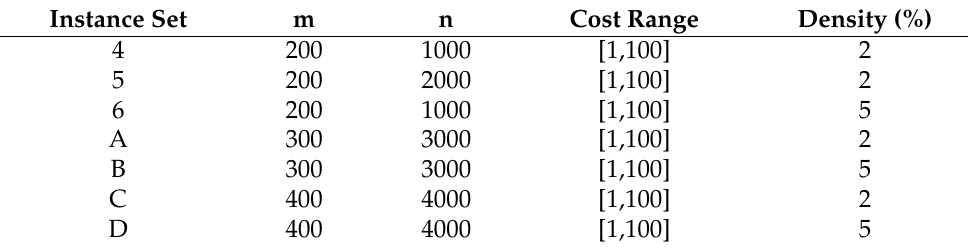
Table 6. Configuration details from SCP instances employed in this